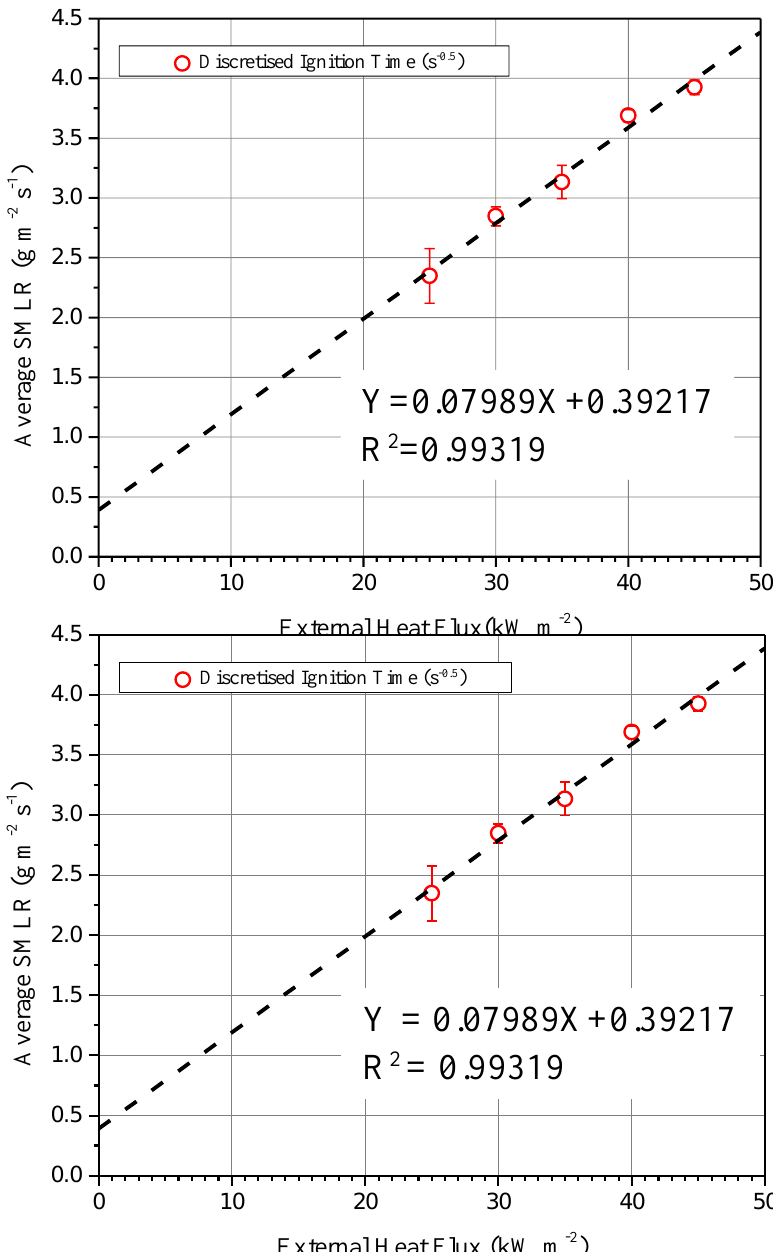
Figure 10. Averaged specific mass loss rate (g m −2 s −1 ) as a function of heat flux (kW m −2 ).